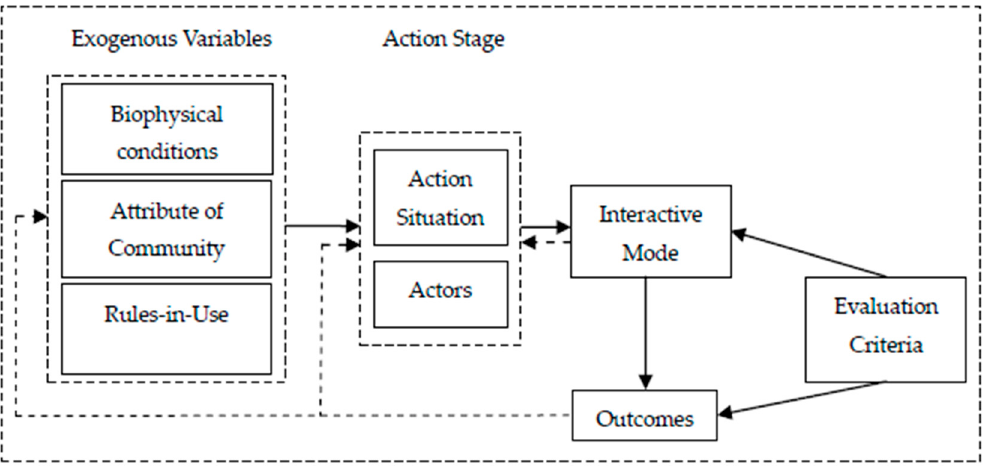
Figure 1. The institutional analysis and development (IAD) framework [43].